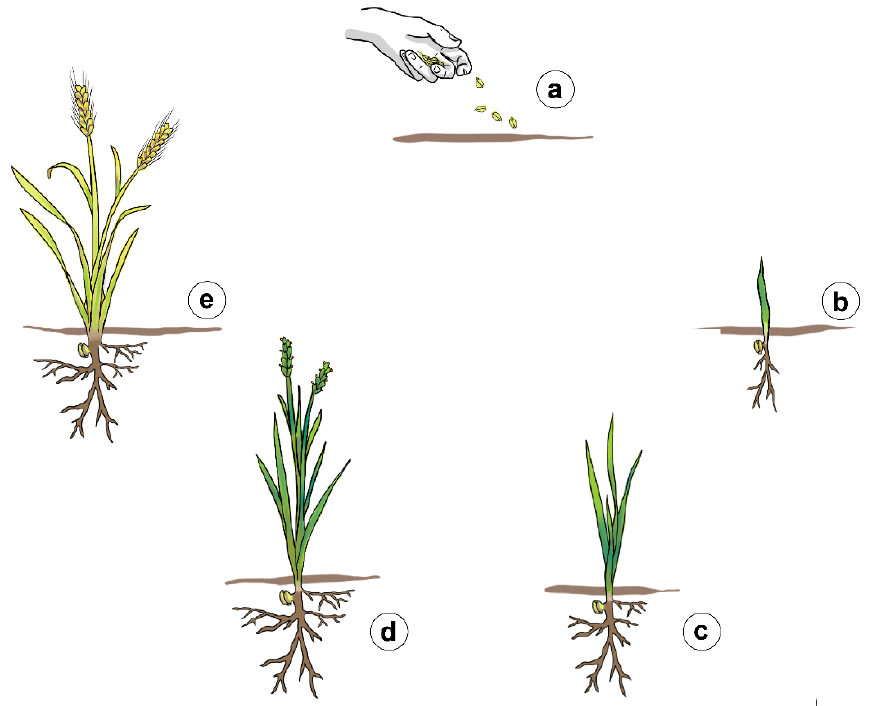
Figure 1. Key stages of the cereal lifecycle: ( a ) dispersal, ( b ) germination, ( c ) vegetative growth, ( d ) flowering, and ( e ) maturation.